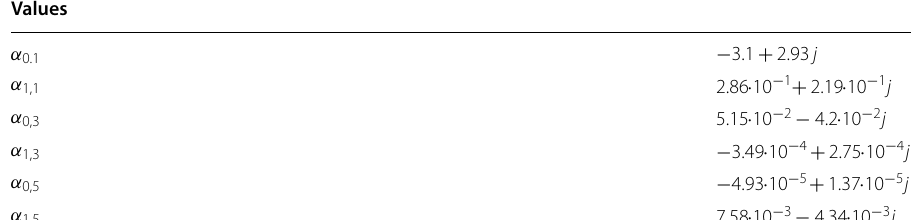
Table 4 PA Model parameters Values α 0.1